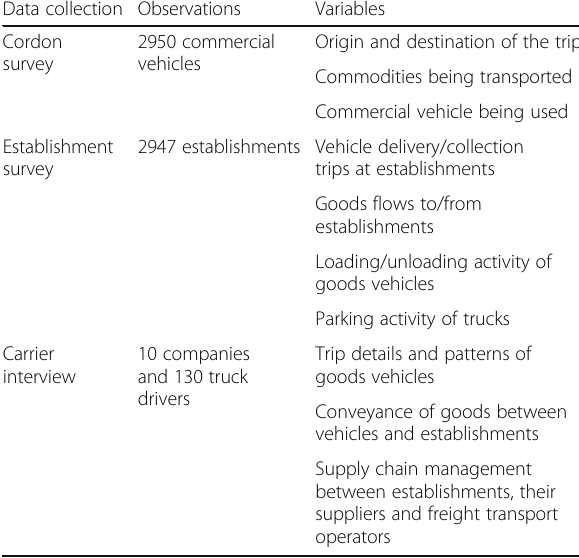
Table 1 Freight data used for the study Data collection